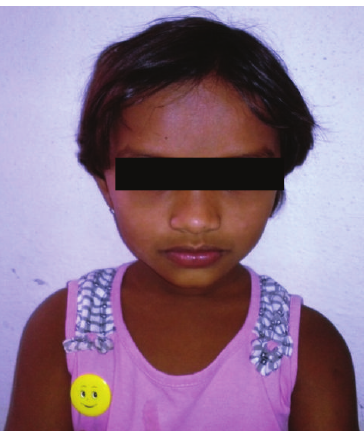
Figure 1: Showing frontal bossing and depressed nasal bridge.